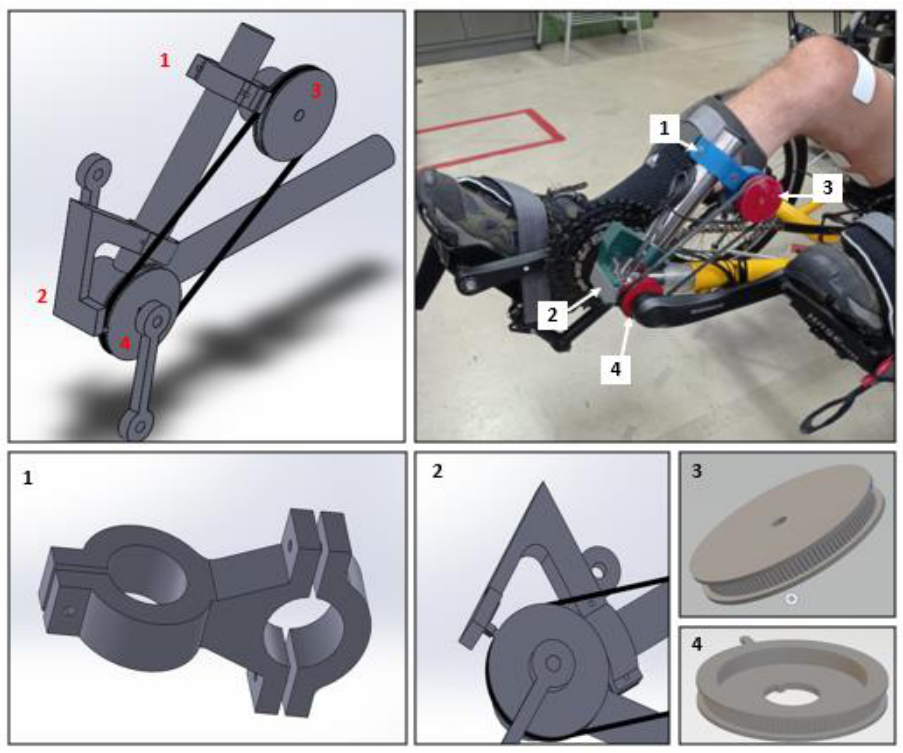
Figure 4. Belt transmission technique to measure the crank angle: ( 1 ) encoder support part; ( 2 ) zero- crossing detection part; ( 3 ) driven pulley attached to the encoder; ( 4 ) driver pulley with rectangular span connected to the crankshaft.